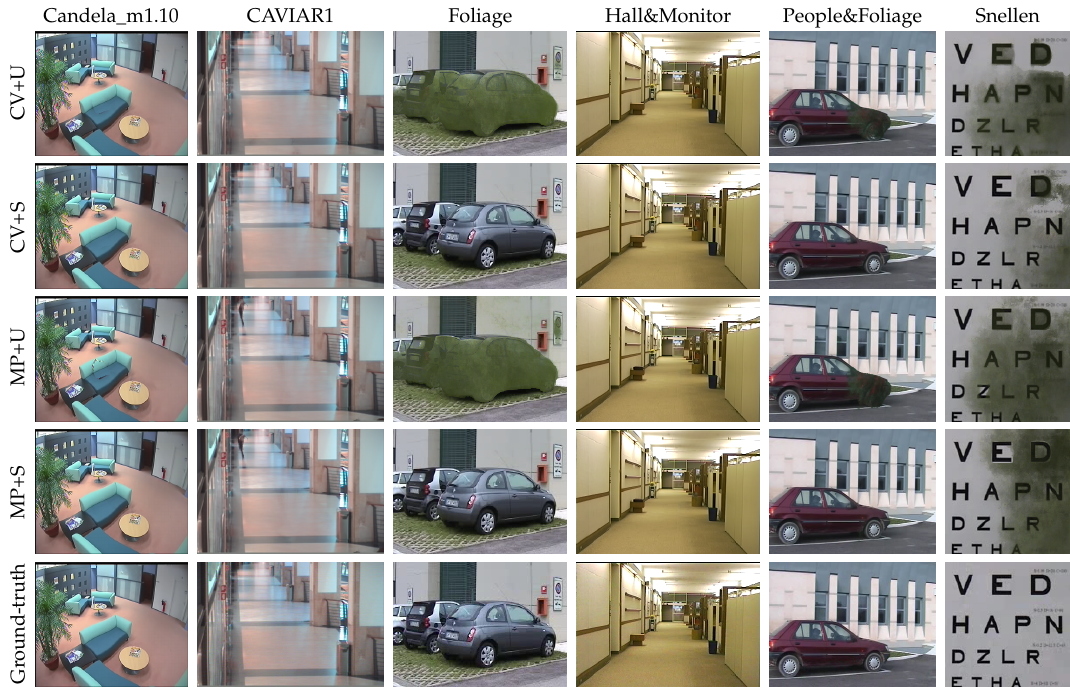
Figure 5. Backgrounds generated by LaBGen-P-Semantic with N = 43 and S = 94 for the video sequences of the SBI dataset with CV+U (1st row), CV+S (2nd row), MP+U (3rd row) and MP+S (4th row). We provide generated backgrounds, along with the corresponding ground-truth (5th row), only for video sequences in which differences are noticeable.